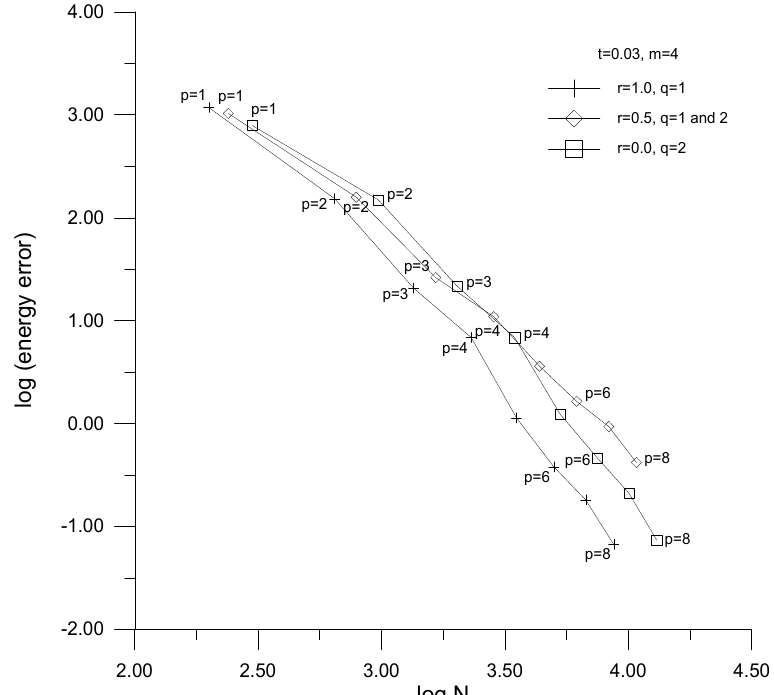
Figure 27. Convergence curves—the membrane shell with the modified transition elements.